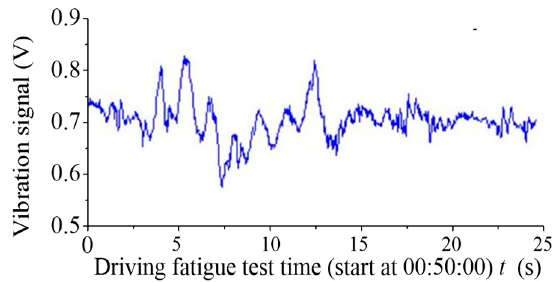
Figure 9. Pressure contour and electrocardio-signal extraction.